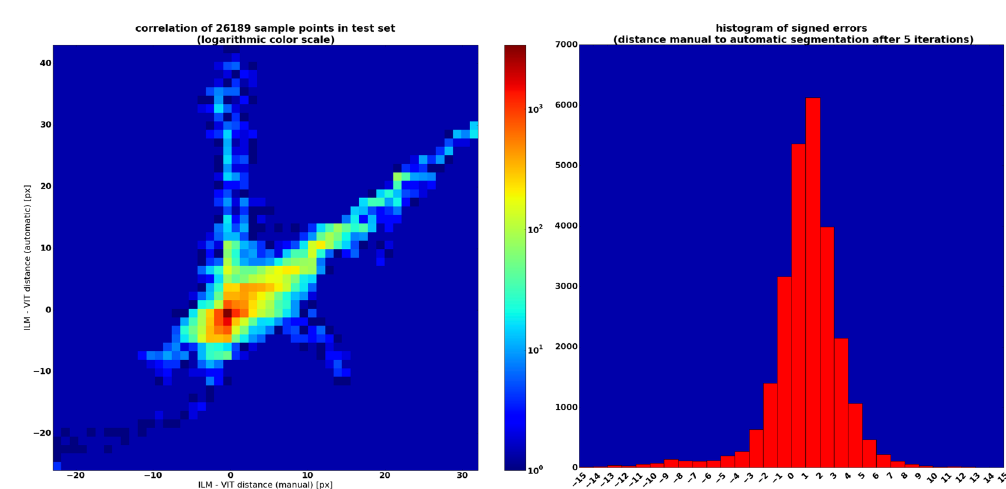
Figure 7. Difference between manual and automatic segmentation (in pixels). Left: correlation between manual and automatic segmentation (note logarithmic colour scale), Right: Histogram of